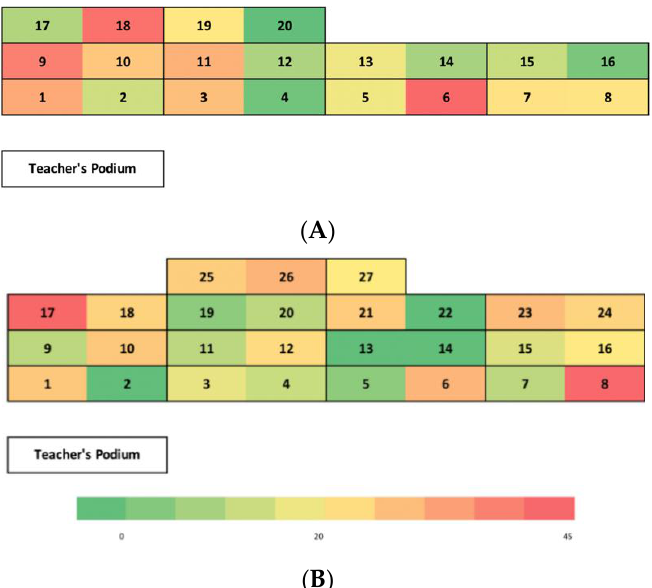
Figure 1. Heat map showing total number of minutes of standing in the intervention (( A ), top) and control (( B ), bottom) groups, and where the standing desks were located in the classroom. The color scale indicates the amount of standing, with less standing in the green, and the most standing in the red. The numbers on the bottom color scale indicate the number of minutes